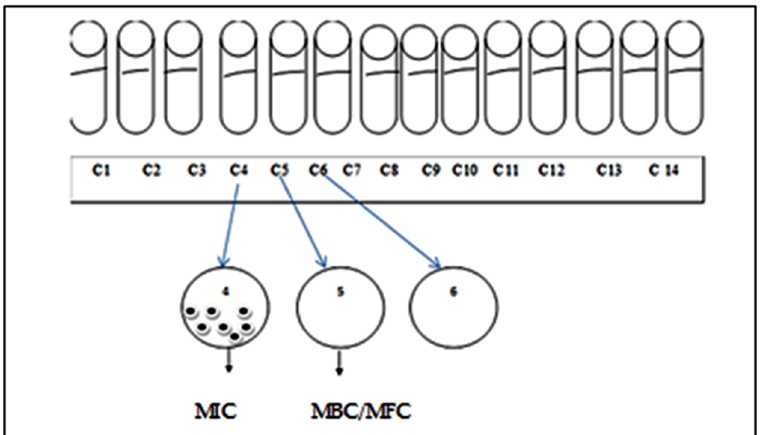
Figure 7. Determination of the Minimum Bactericidal Concentration (MBC) and Minimum Fungicidal Concentration (MFC) of essential oils. In this example the MIC is C4 where the strains are alive but inhibited from growth in the tube and the MBC or MFC is C5 where the strains are totally killed by the EOs.